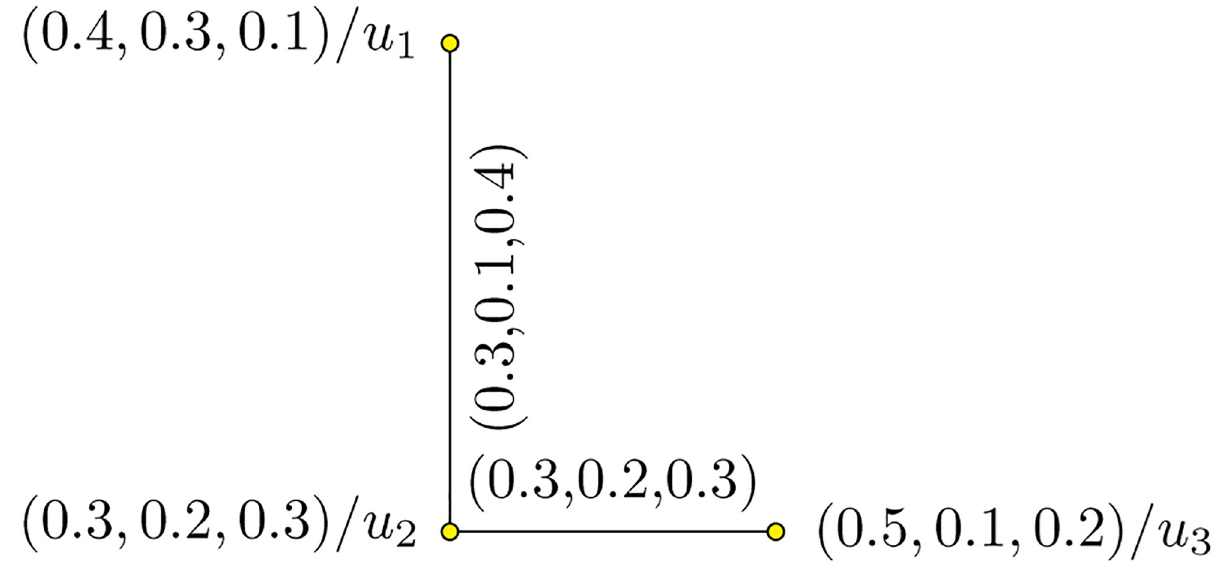
Fig 5. Y ¼ ð U ; W Þ . 1 1 1